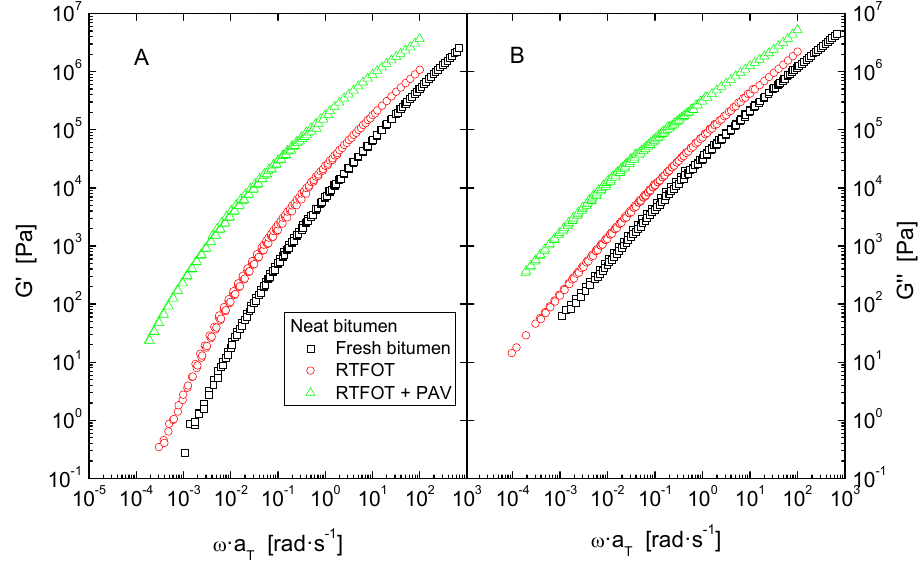
and ( B ) Unaged bitumen modified by DSA and ageing effects on the modified bitumen.